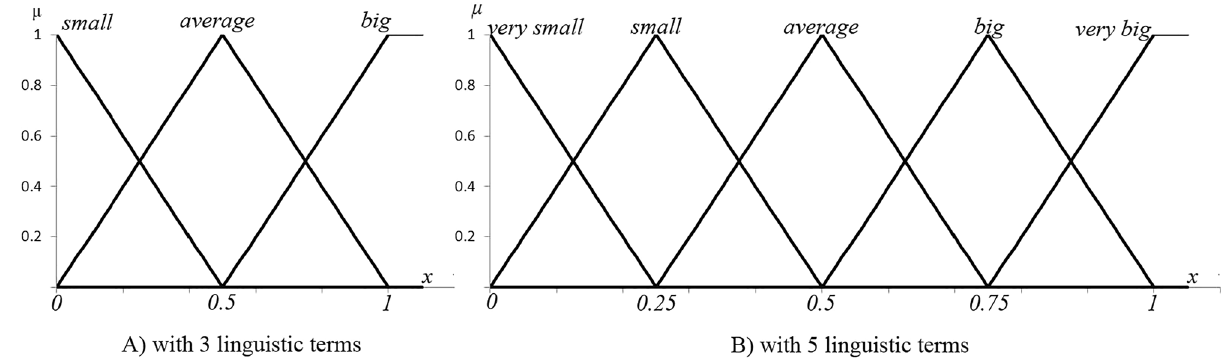
Figure 9. Symmetric triangular membership function with 3 linguistic terms and 5 linguistic terms respectively.